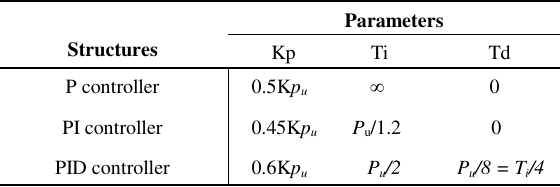
Table 1. Formulas for the controller parameters in the Ziegler-Nichols closed loop method.